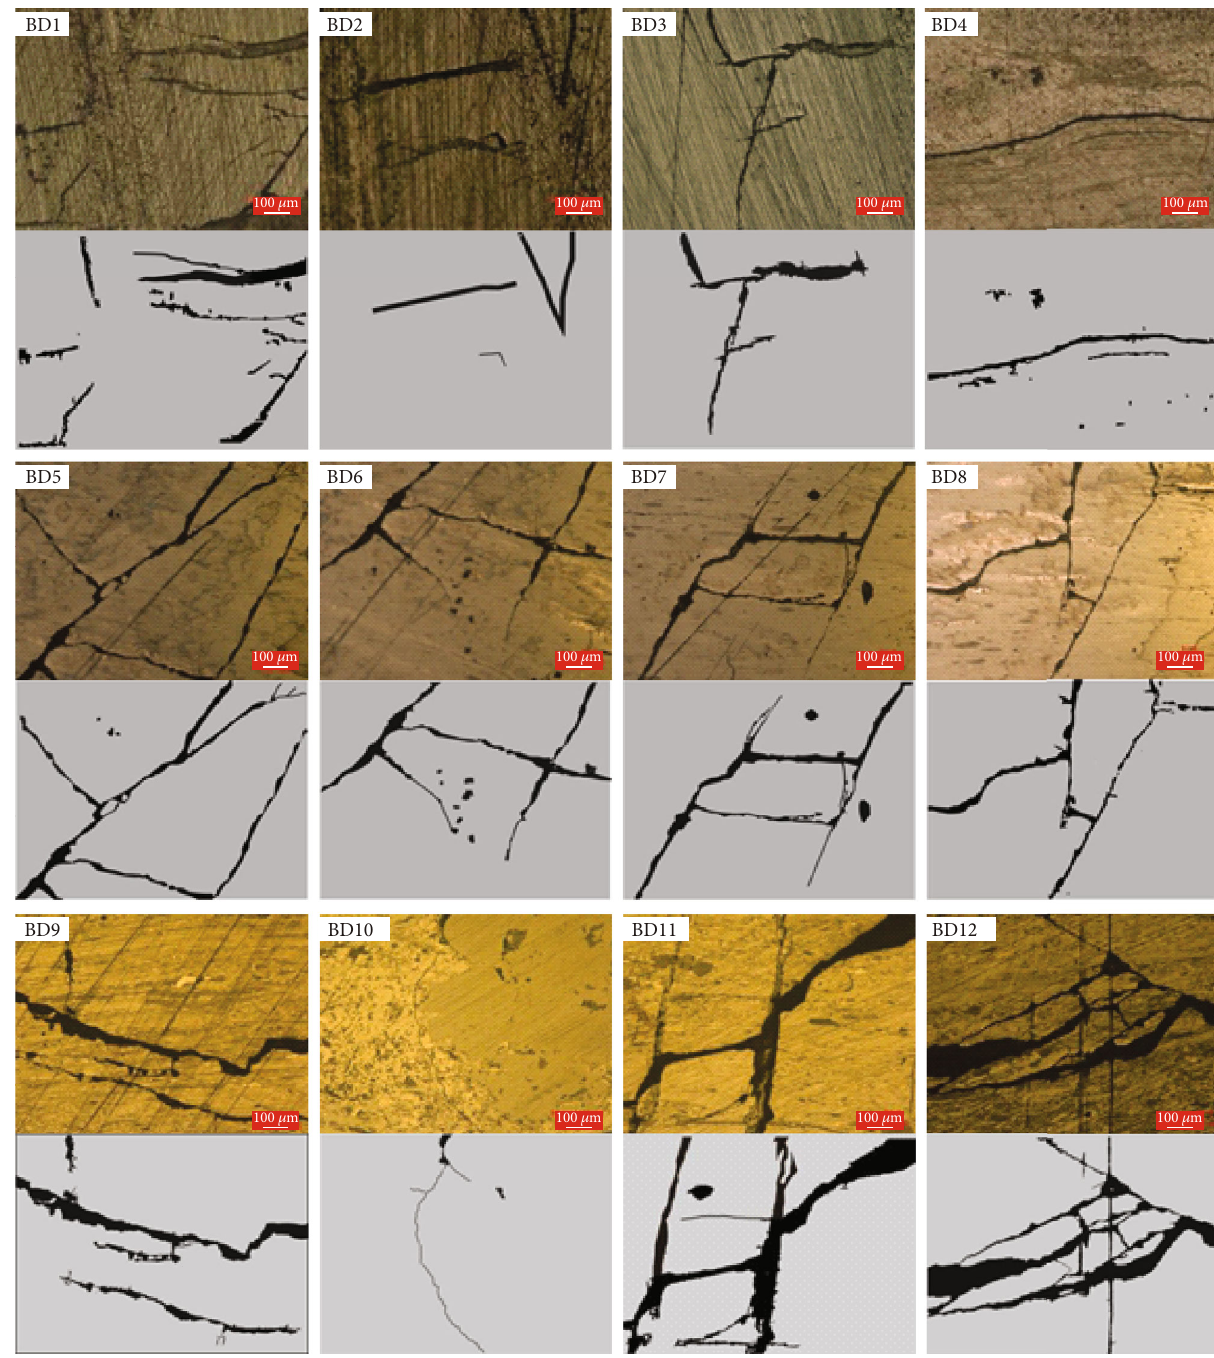
Figure 5: Coal fracture distribution in the